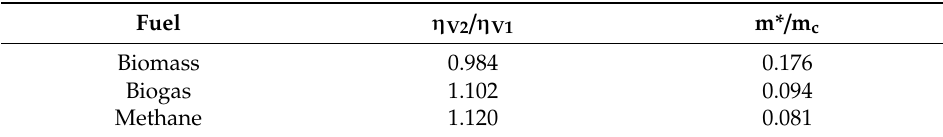
Table 6. Summary of the results of calculations carried out for the di ff erent calorific values of fuel for selected cycles. Fuel η V2 / η